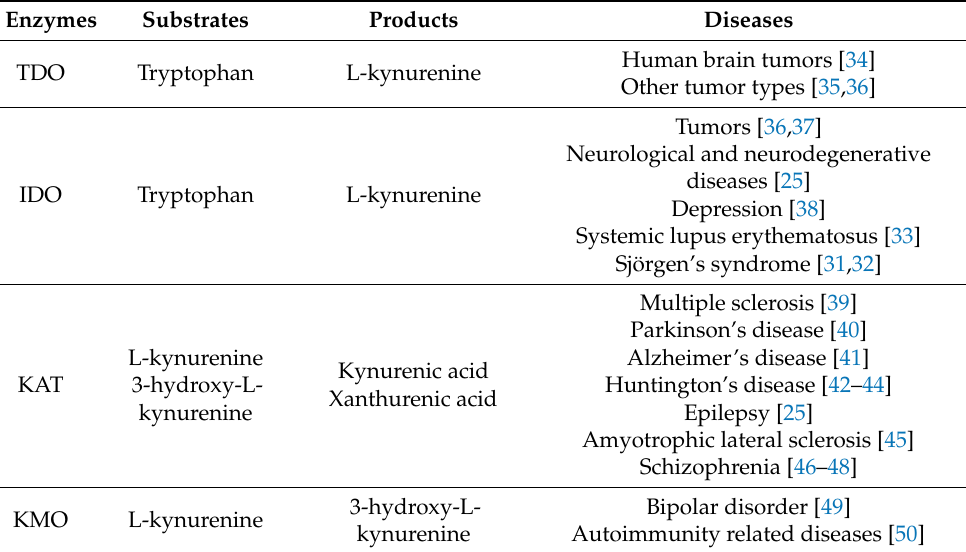
Table 1. The enzymes of the tryptophan-kynurenine pathway and related